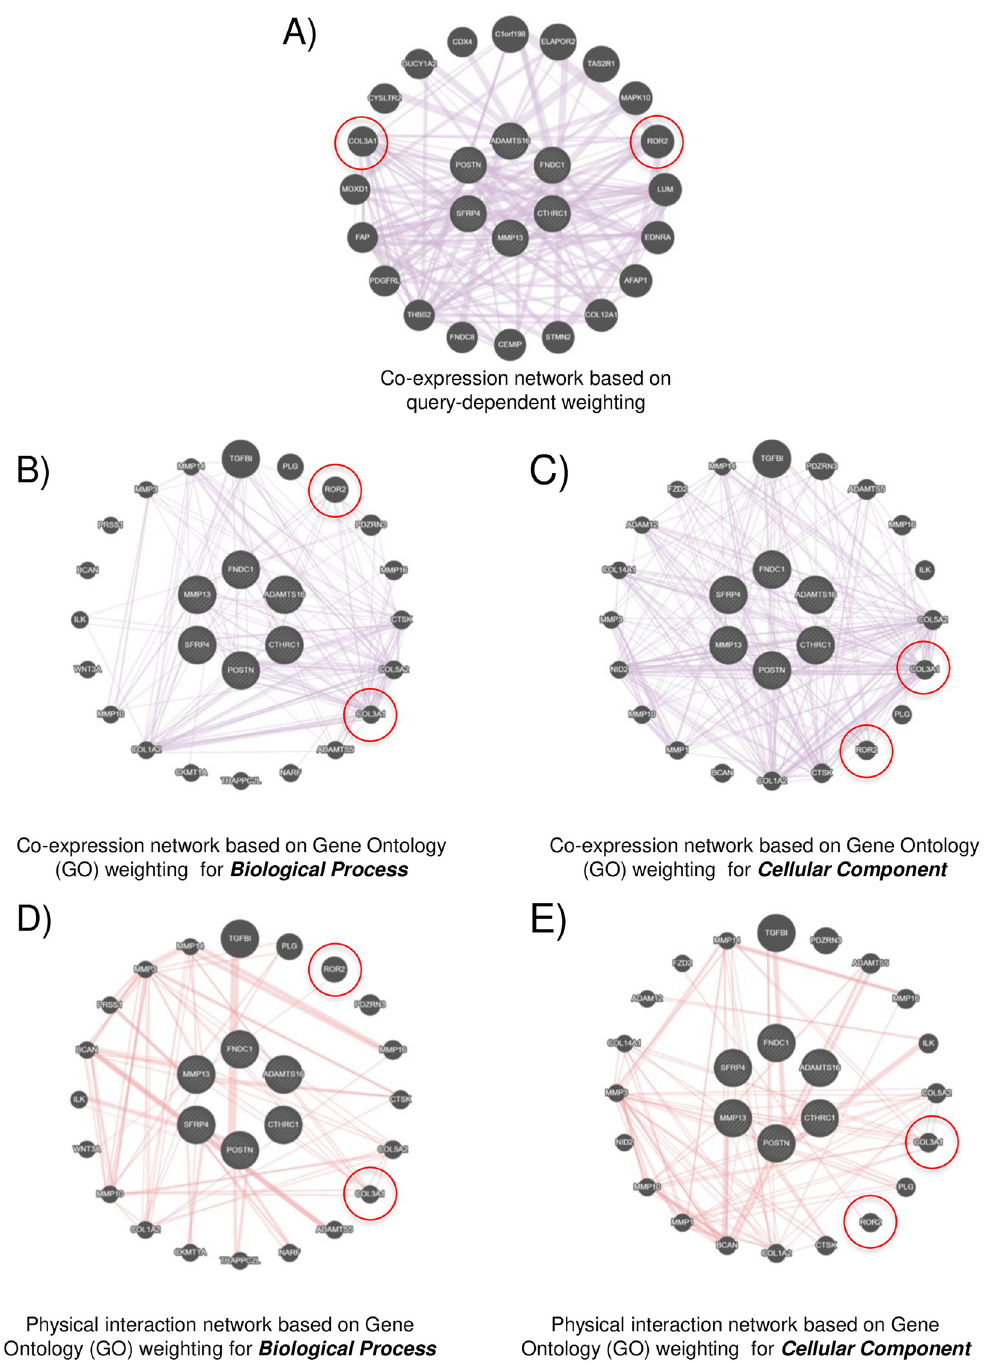
Fig 7. Functional Network analysis of CTHRC1 and its 5 hub genes. Network analysis of CTHRC1 and its 5 hub genes (POSTN, MMP13, FNDC1, SFRP4 and ADAMTS16) identifies COL3A1 and ROR2 genes in both co-expression and physical interaction categories. A) Image shows co-expression network based on query genes, B-C ) Images shows co- expression network based on (B) biological processes and (C) cellular component. D-E) Image shows physical interaction network based on (D) biological processes and (E) cellular